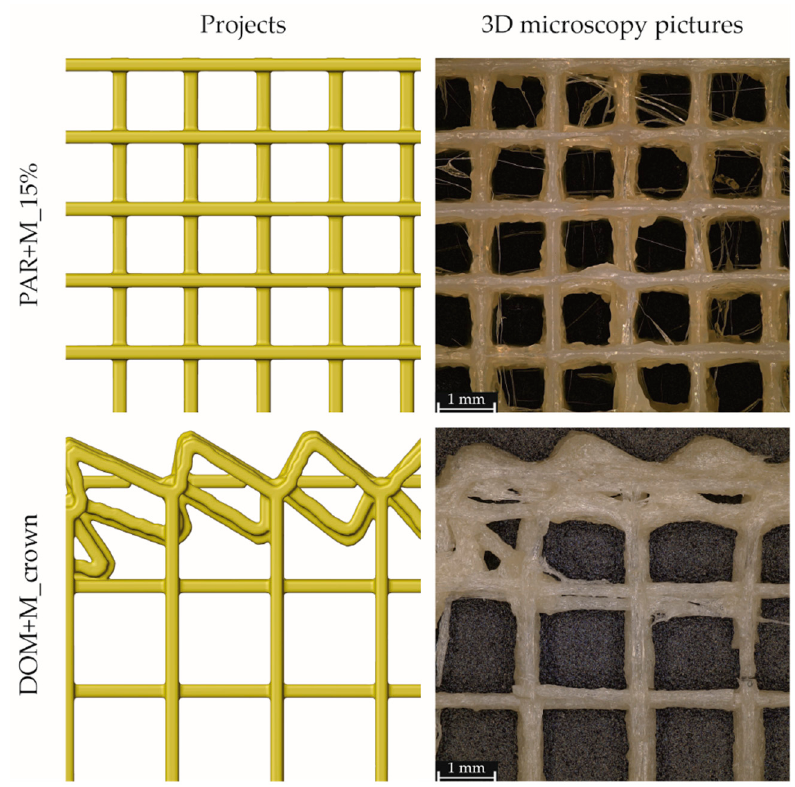
Figure 5. Top views on PAR + M_15% and DOM_crown tablets: comparison of designs received by reversed voxelization ( left ) and obtained by 3D microscopy ( right ).